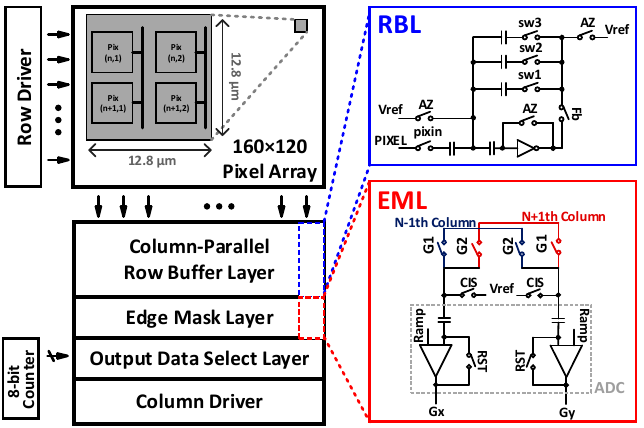
Figure 2. Block diagram of the proposed CIS with the built-in edge-detection mask.